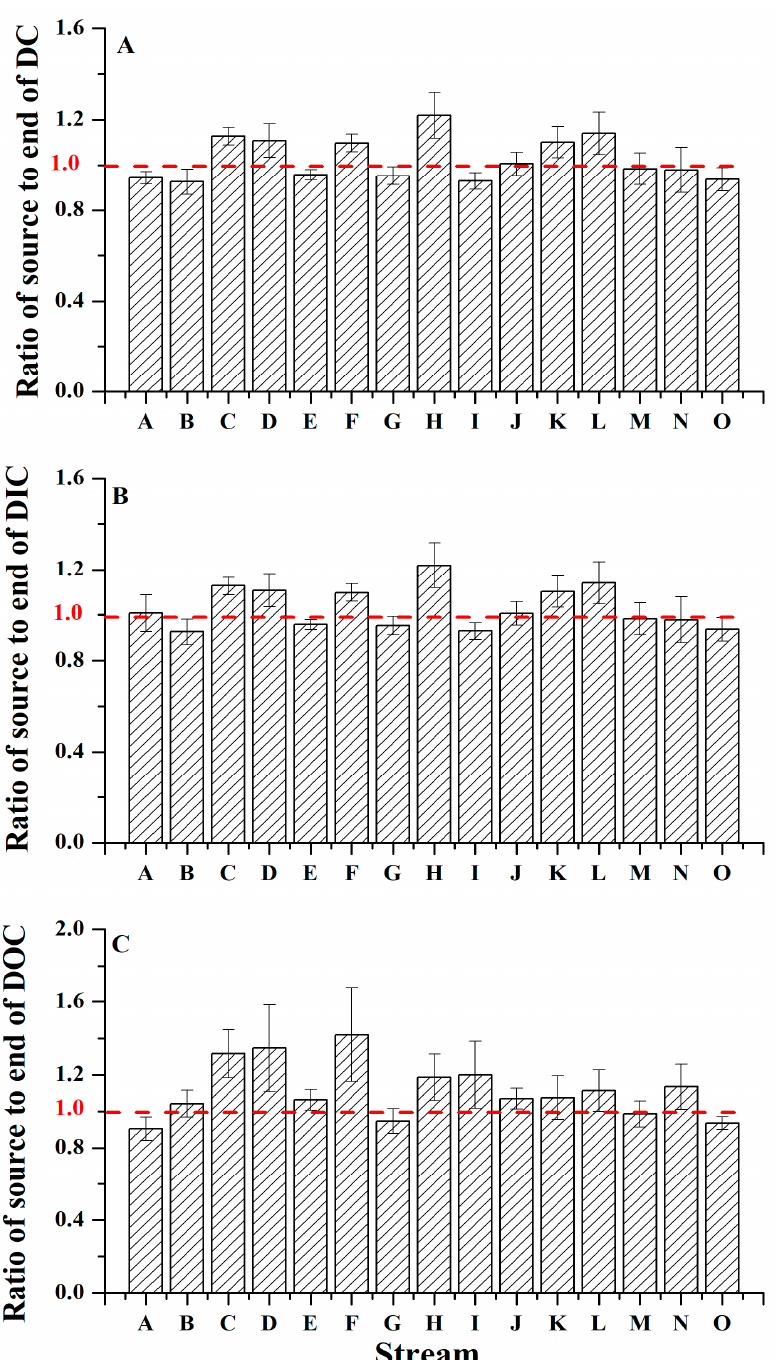
Figure 7. The ratios of dissolved carbon (DC) stocks from source waters to export waters in the subalpine forest streams in the upper reaches of the Yangtze River from 11 July 2015, to 2 August 2016. Total dissolved carbon stock (DC, ( A )); dissolved inorganic carbon stock (DIC, ( B )); dissolved organic carbon stock (DOC, ( C )). Each bar is the average of 13 sampling times for each forest stream, and the error bars are the standard deviations of 15 streams during every period. A–O are the sampled streams in the study.